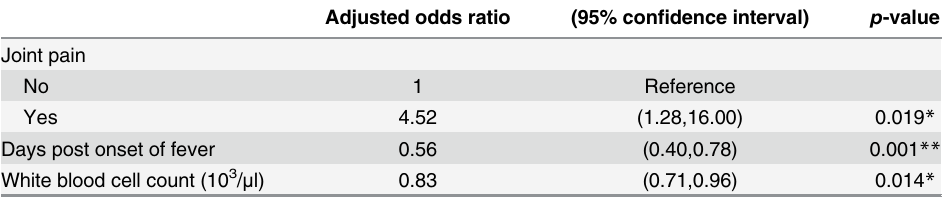
Table 2. Multivariable associations with having a confirmed infection l= with CHIKV in patients of the APCF of the EWMSC, T&T (Dec 2013 – Nov 2014). Adjusted odds ratio (95% con fi dence